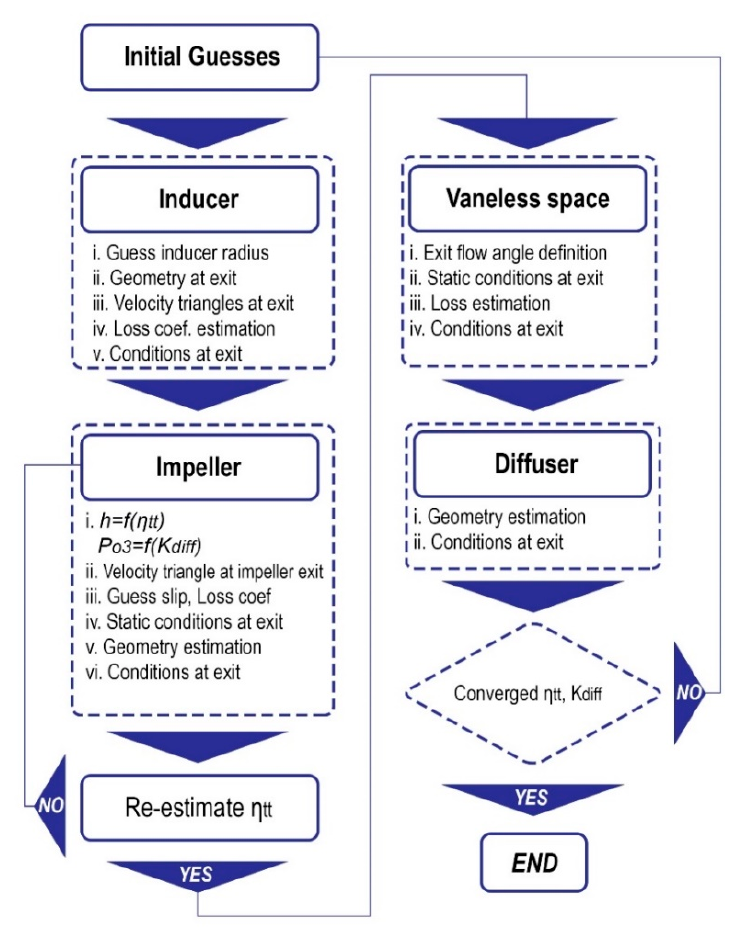
Figure 4. One-dimensional mean-line design methodology.